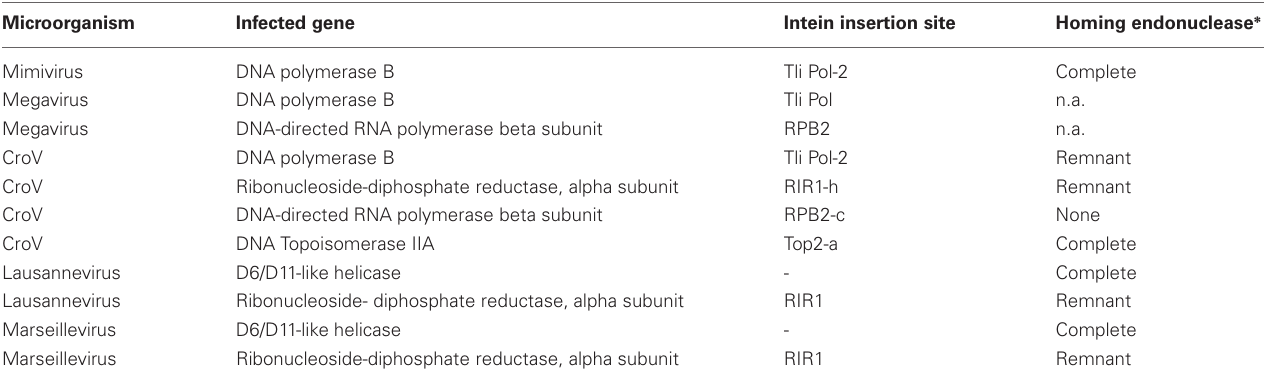
Table 3 | Inteins and their homing endonucleases in